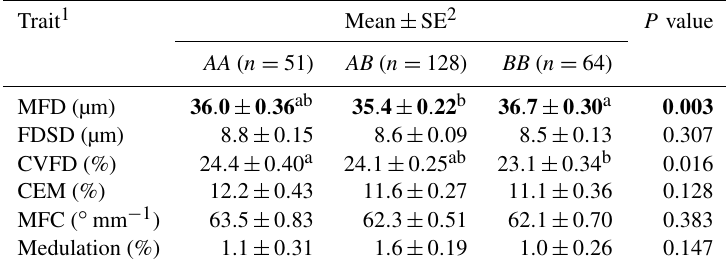
Table 2. Association of ovine KRTAP6-1 genotypes and wool traits in New Zealand Romney